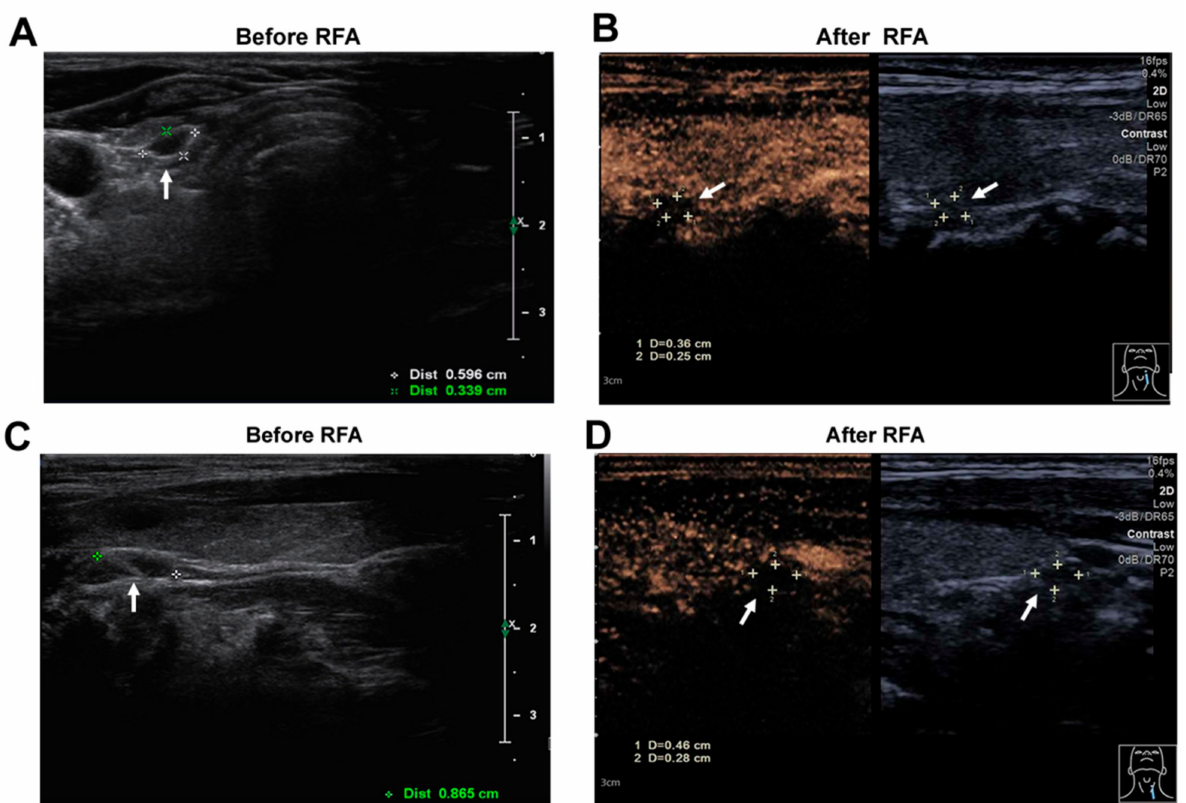
Figure 3. Changes of two left parathyroid glands before and after RFA by neck ultrasonography. US examination revealed 6 mm × 3 mm × 7 mm ( A ) and 9 mm × 6 mm × 3 mm ( C ) parathyroid nodules posterior to the left lobe of the thyroid gland pre-RFA. Two months after RFA, nonenhancement area (arrows) covered PHPT nodules on contrast-enhanced ultrasound (CEUS) ( B , D ), and the volume of the nodules decreased to about 0.01 mL (3.6 mm × 2.5 mm × 2.8 mm, superior left) ( B ) and 0.02 mL (4.6 mm × 2.8 mm × 2.7 mm, inferior left) ( D ). Ultimately, the patient was diagnosed with MEN1, based on their medical history and examination data as follows: (1) gastrinoma; (2)